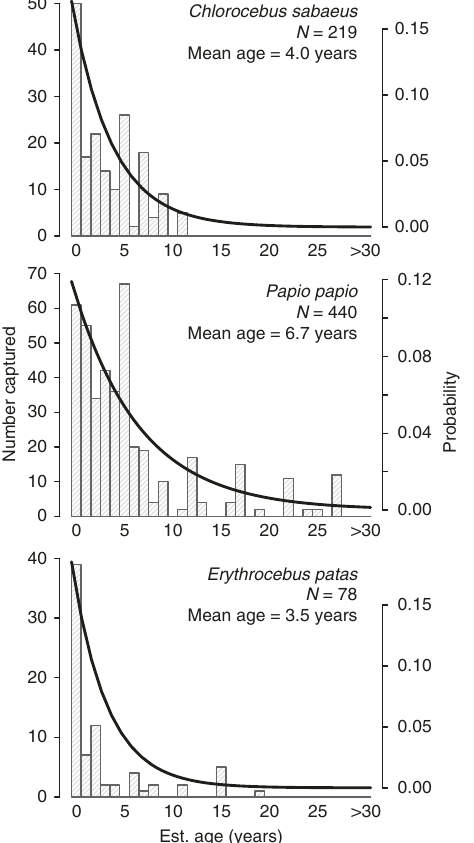
Fig. 3 Age distributions of collected monkeys. Panels show the observed age distributions of collected monkeys with exponential distributions (thick line) with rates equal to the mean age of collected individuals, for Chlorocebus sabaeus , Papio papio , and Erythrocebus patas , respectively